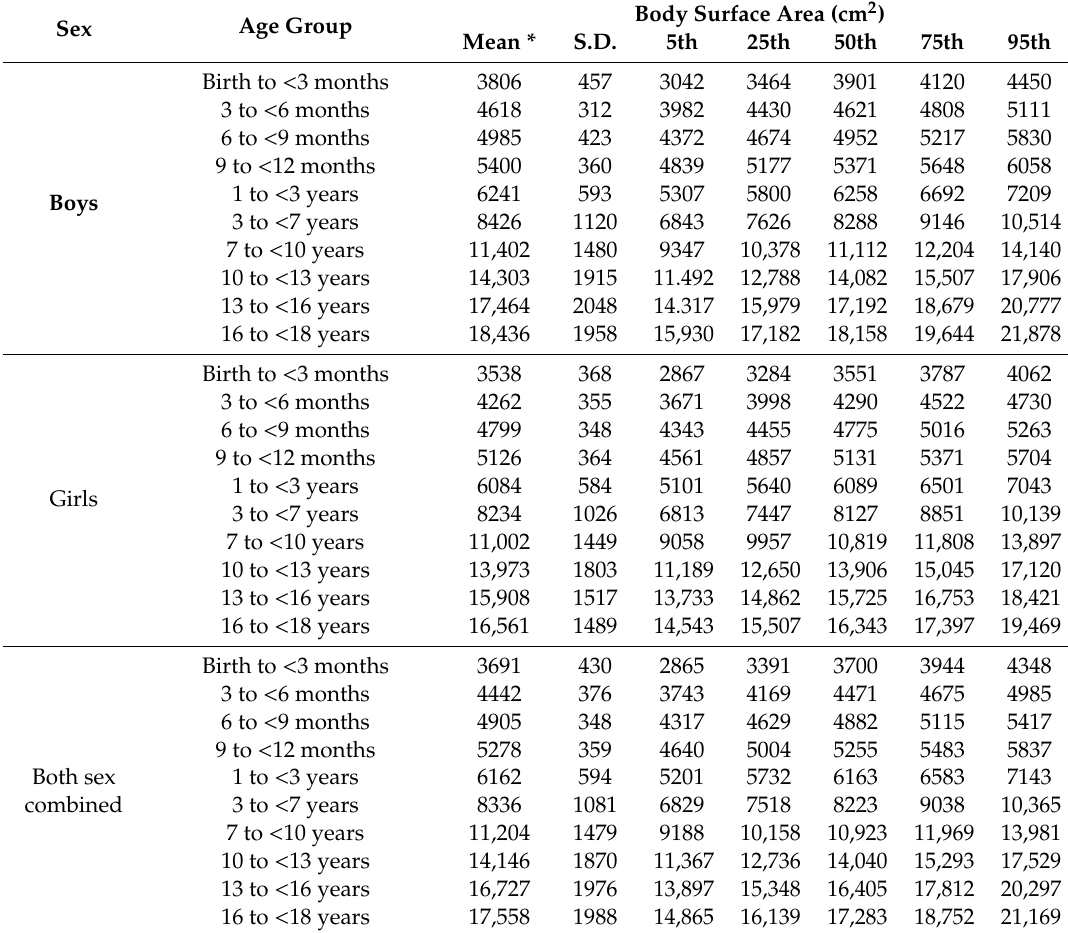
Table 2. Recommended values and statistics for body surface area according to age group.